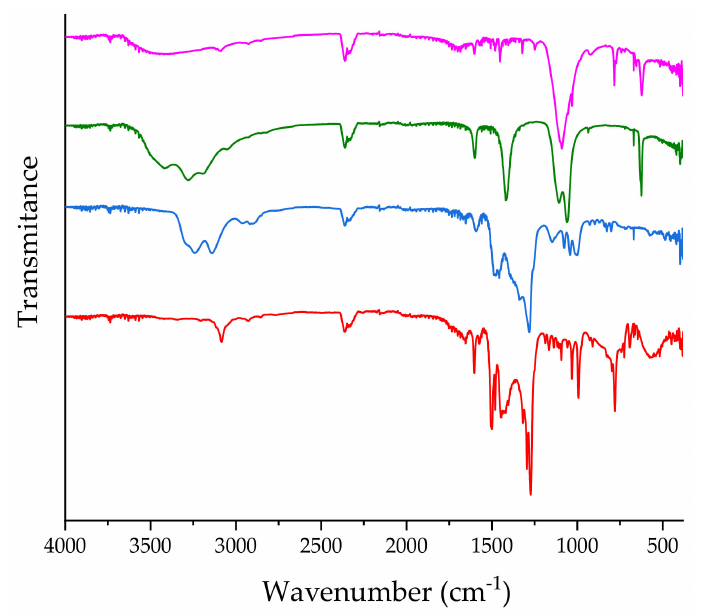
Figure 3. The ATR-IR spectra of the reaction mixtures containing CblCN-Pd conjugates: 1 (pink), 2 (green), 3 (blue) and 4